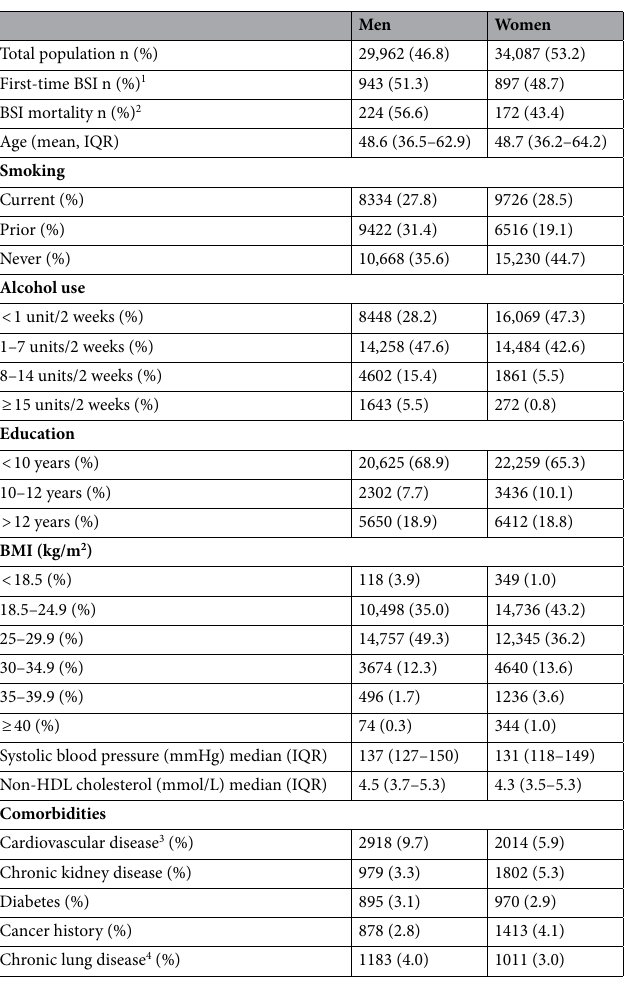
Table 1. Baseline characteristics of the study population at inclusion in HUNT2, n = 64,040. BSI bloodstream infection, n numbers, IQR interquartile range, BMI body mass index, HDL high-density lipoprotein. 1 Percentage of total first-time BSI in both sexes. 2 BSI mortality was defined as all-cause mortality within 30 days after a BSI. Percentage of BSI mortality on both sexes. 3 History of myocardial infarction, angina pectoris and/or stroke. 4 History of chronic obstructive pulmonary disease or